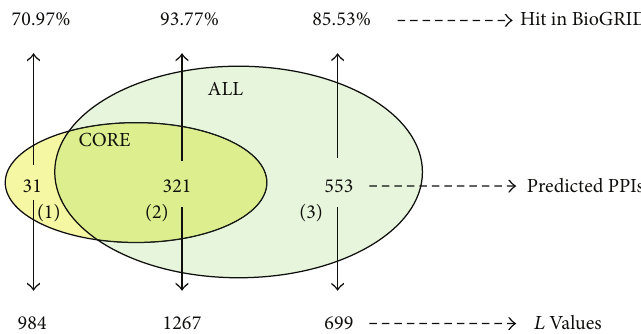
Figure 4: The overlap and difference between CORE and ALL are estimated with the dataset BioGRID and statistical likelihood benchmark 𝐿 .